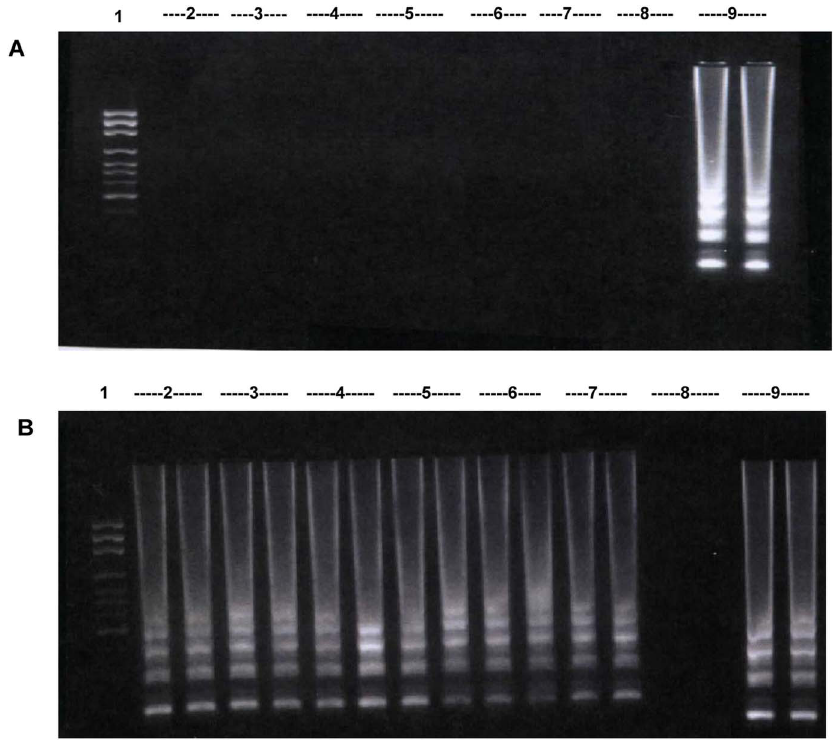
Fig. 1. Demonstration of analytical specificity of pap 31 LAMP. A. Lane 1: 100 bp ladder, Lane 2–7: products from LAMP reactions containing genomic DNA from R. conorii, R. rickettsii, R. typhi, Orientia tsutsugamushi, L. interrogans, and B. henselae , respectively. Lane 8: negative control, Lane 9: positive control. B. LAMP assay performed using a combination of B. bacilliformis genomic DNA (10 copies/reaction) and other bacterial genomic DNA(100 copies/reaction). Lane 1: 100 bp ladder, Lane 2–6, 9: B. bacilliformis plus either R. conorii , or R. rickettsii , or R. typhi , or Orientia tsutsugamushi , or L. interrogans , or B. henselae , respectively. Lane 7: positive control, Lane 8: negative control.